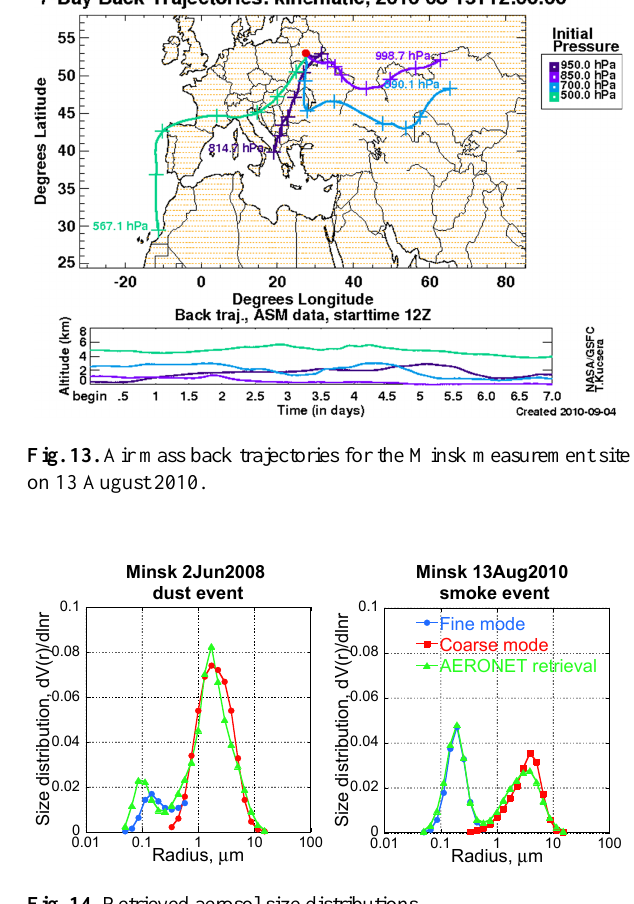
Fig. 14. Retrieved aerosol size